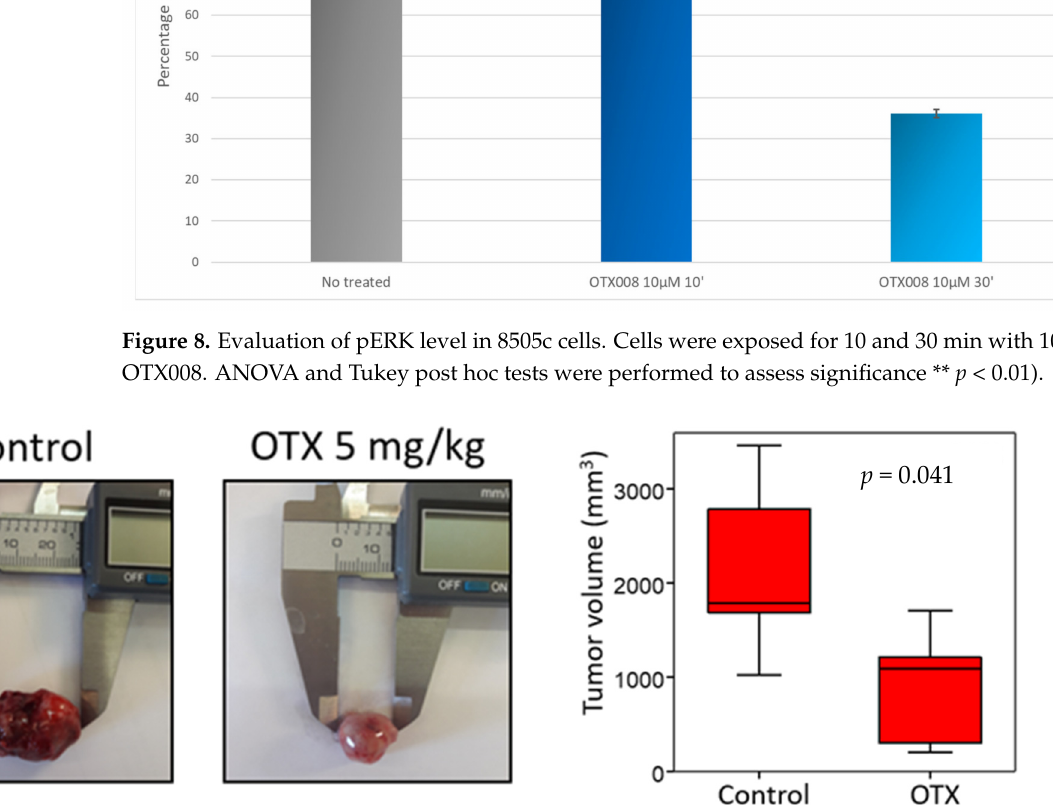
Figure 8. Evaluation of pERK level in 8505c cells. Cells were exposed for 10 and 30 min with 10